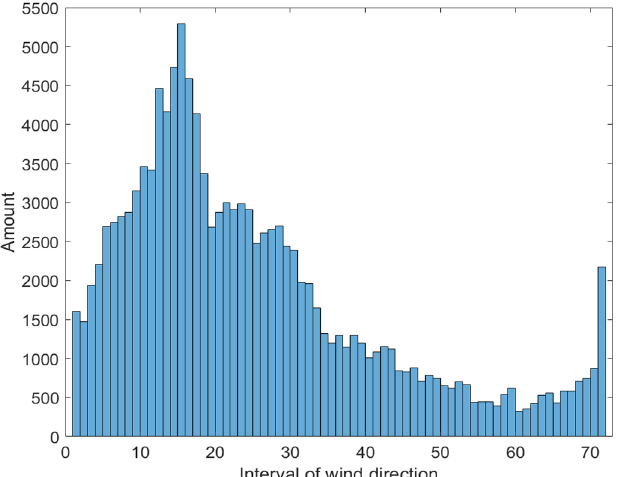
Figure 9. Quantitative distribution of filtered Full DDM data in different wind direction intervals.